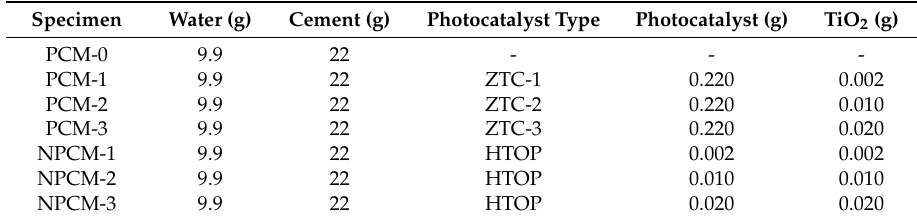
Table 4. The composition of the photocatalytic cement-based material.